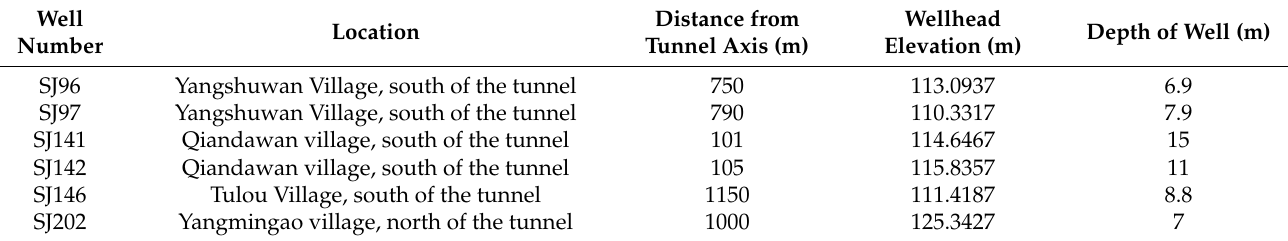
Table 3. Drained civilian Wells.